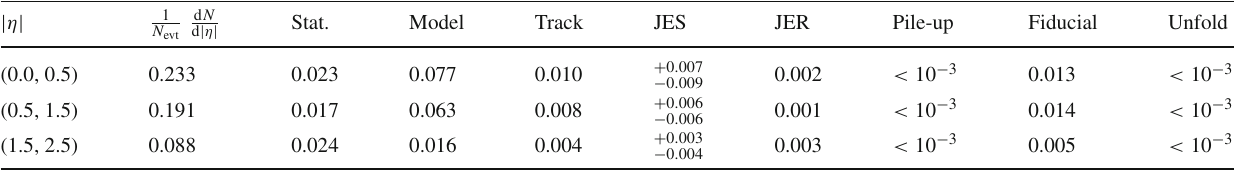
associated with non- b -jets, and including invisible decays, along with S